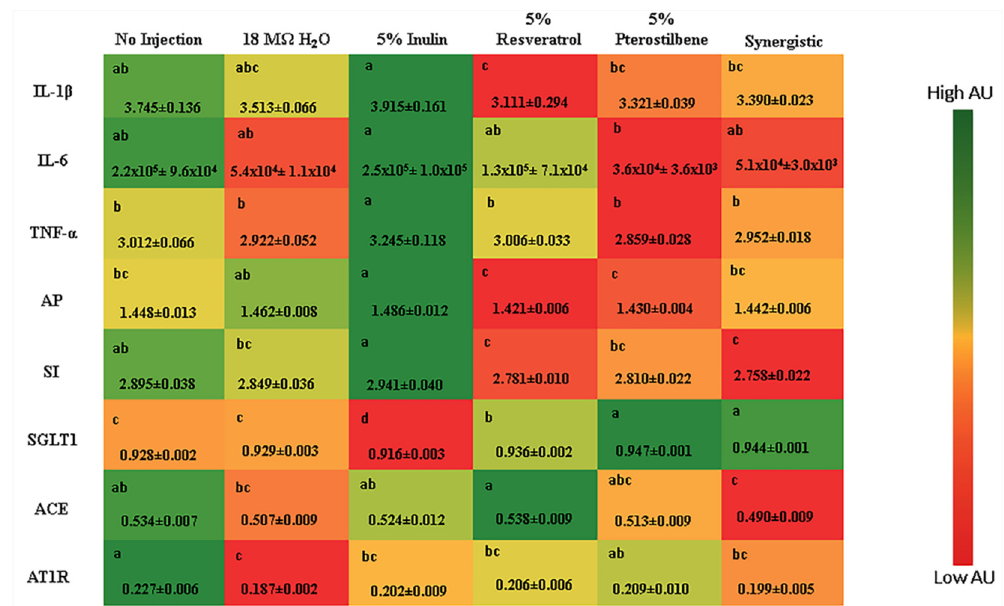
Figure 2. Intestinal gene expression of proteins involved with the immune system, BBM functionality and hypertension. Values are the means ± SEM ( n = 8). a–c Per gene, treatment groups not indicated by the same letter are significantly different ( p < 0.05). IL-1 β : interleukin 1 β ; IL-6: interleukin-6; TNF- α : tumor necrosis factor alpha; AP: aminopeptidase; SGLT1: sodium-glucose transport protein 1; SI: sucrose isomaltase; ACE: angiotensin-converting enzyme; AT1R: angiotensin II receptor type I.